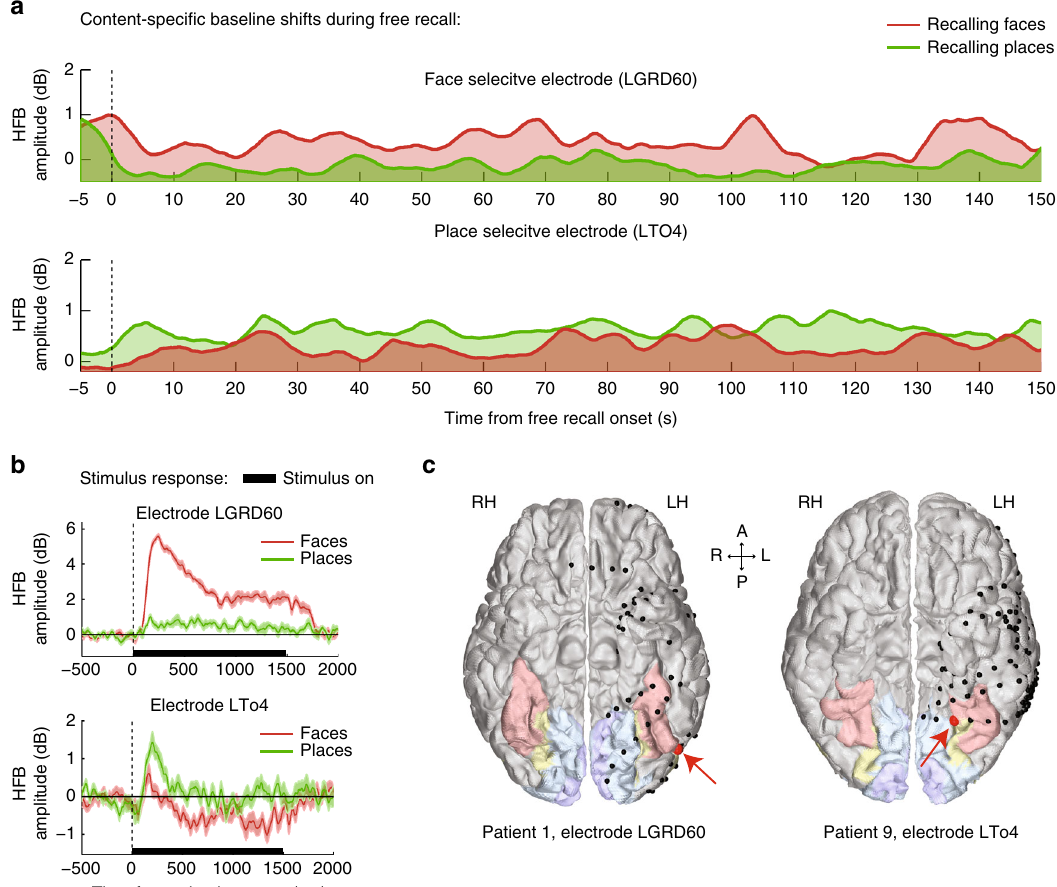
Fig. 2 Baseline shifts during free recall in two representative electrodes. a An example of a face-selective electrode (top) and a place-selective electrode (bottom) showing a sustained baseline increase during free recall of pictures from their preferred category. HFB time-courses were normalized relative to rest and smoothed using a triangular window of 5 s for visualization purposes. b Stimulus response of the two electrodes during the picture viewing stage, showing a clear preference to either faces or places (shaded areas represent SEM). c Anatomical locations of the two electrodes (marked in red) in relation to primary visual cortex (blue), intermediate visual areas (yellow), and the fusiform gyrus